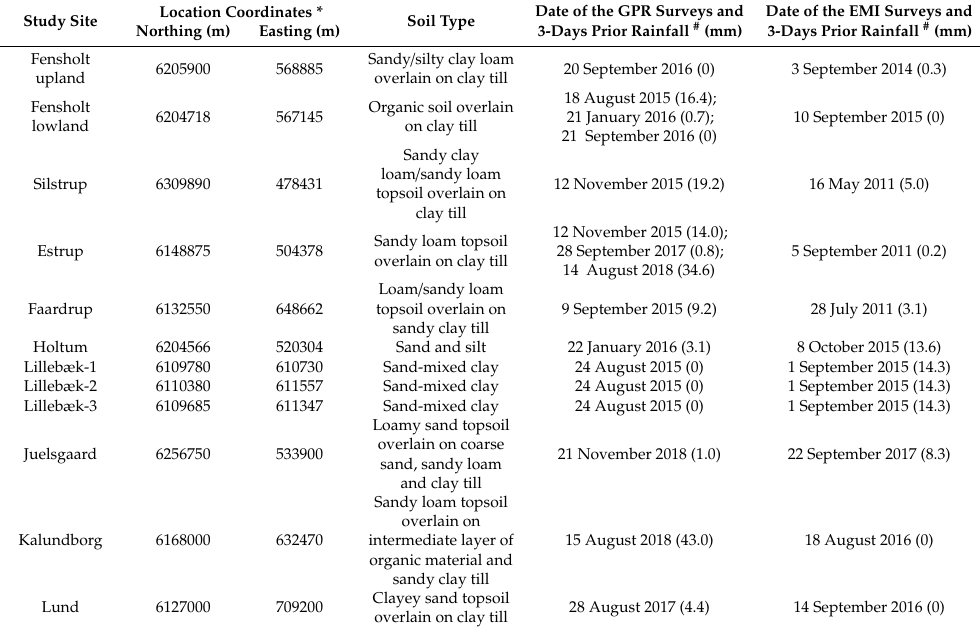
Table 1. Summary of the study sites’ location, soil type, dates of the ground penetrating radar (GPR) and electromagnetic induction (EMI) surveys, and total precipitation (in brackets) three-days prior to the surveys.